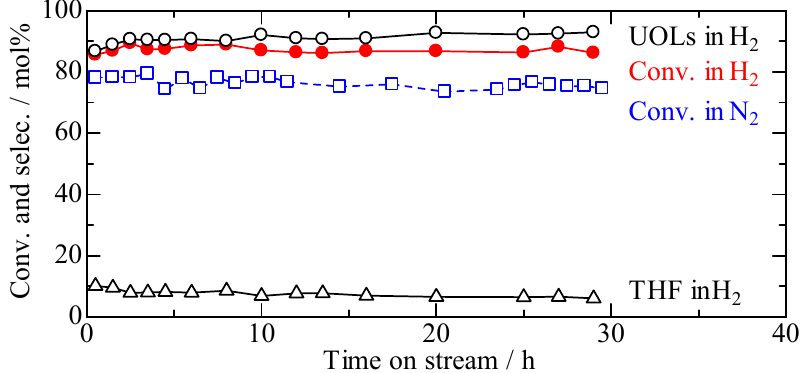
Figure 8. Long-run stability in the conversion of 1,4-BDO over YZrO calcined at 900 °C. Reaction temperature, 325 °C; carrier gas flow rate, 30 cm 3 min − 1 ; W / F = 0.31 h.